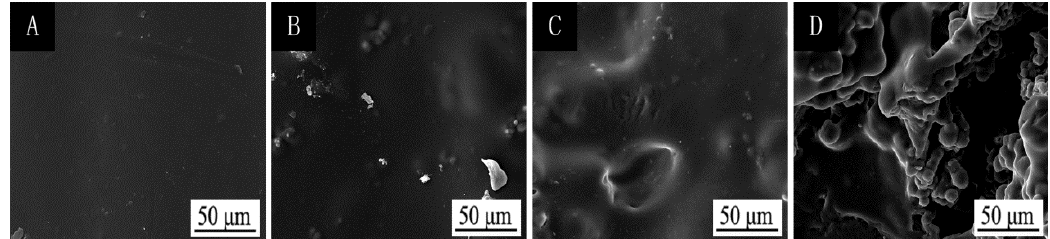
Figure 11. SEM image of water-based paint film with different mass fractions: ( A ) 0; ( B ) 5.0%; ( C ) 10.0%; ( D ) 30.0%.